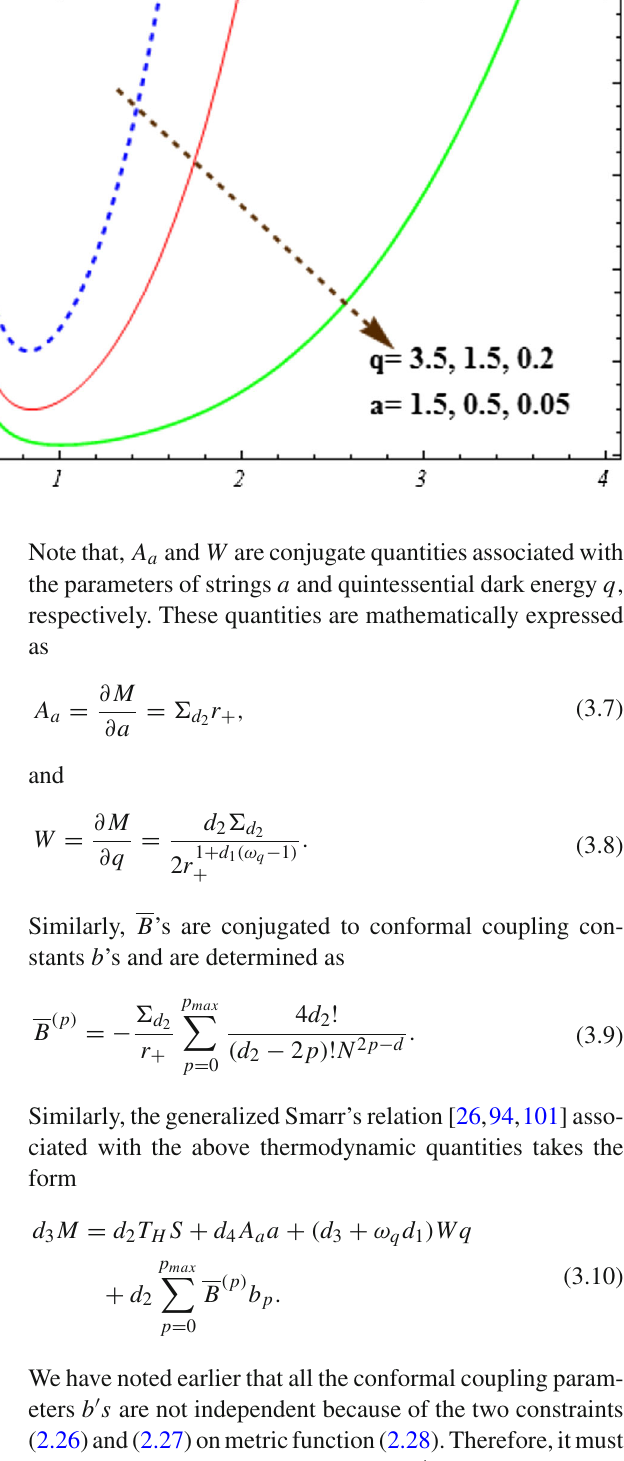
Fig. 6 The plot of temperature T H (Eq. (3.3)) vs r + for fixed values of l = 1, δ d , 2 n − 1 = 100, ω = − 0 . 7, (cid:13) = 1, n = 2, q d − 2 d = 6 and H A = 0 .